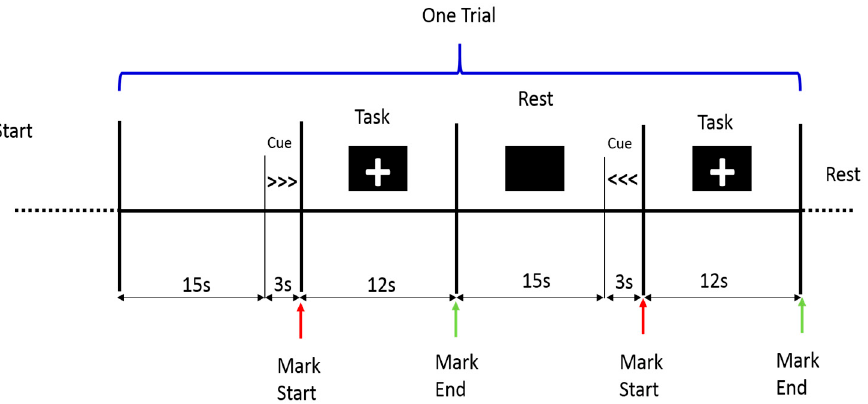
Figure 3. Experimental protocol timeline during the ankle joint movement. The trial started with 15 s rest until the cue signal appeared on the screen to indicate the right or left movements, then the subject moved his ankle for 12 s until the (+) sign disappeared.